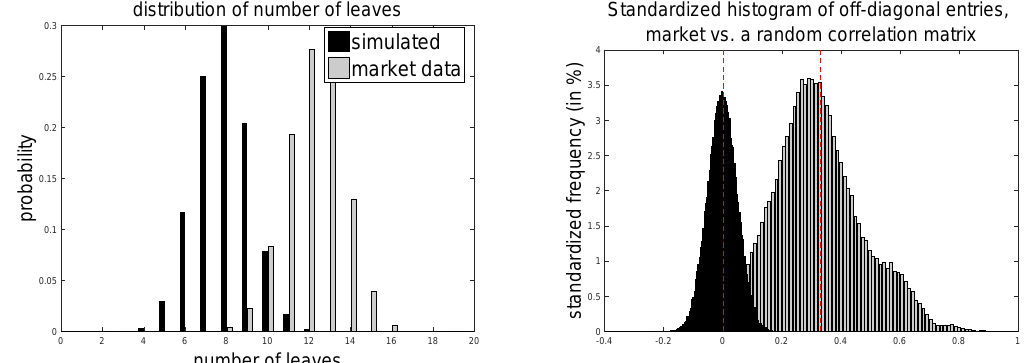
Figure 6: Left: Number of leaves encountered in uniformly simulated (black) vs. CDS data-based (gray) MSTs. Right: Standard- ized frequencies of the off-diagonal elements of a uniformly simulated (black) and our market correlation matrix (gray). The latter is significantly shifted to the